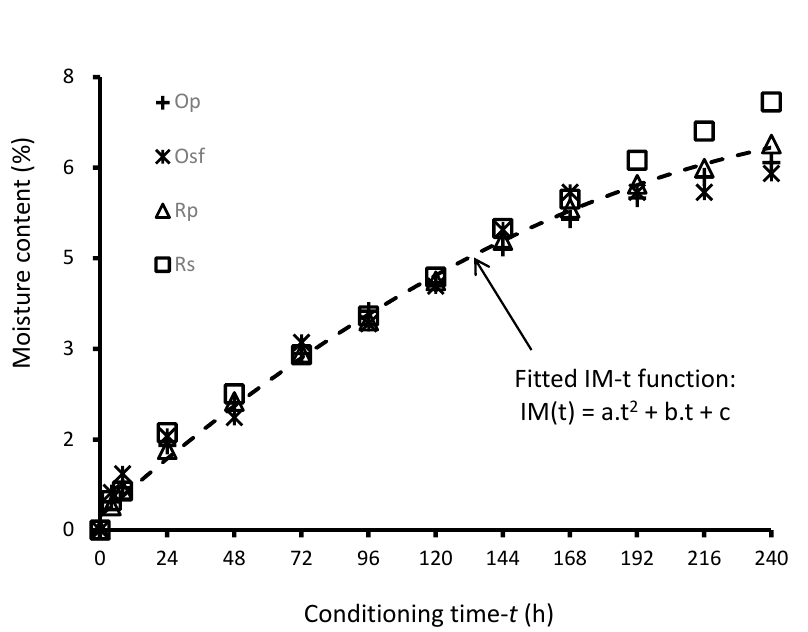
Figure 3. The dependence of moisture content of raw materials on conditioning time.